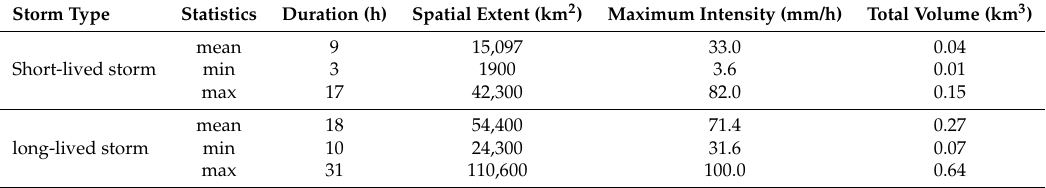
Table 1. Storm characteristics for short- and long-lived event types.